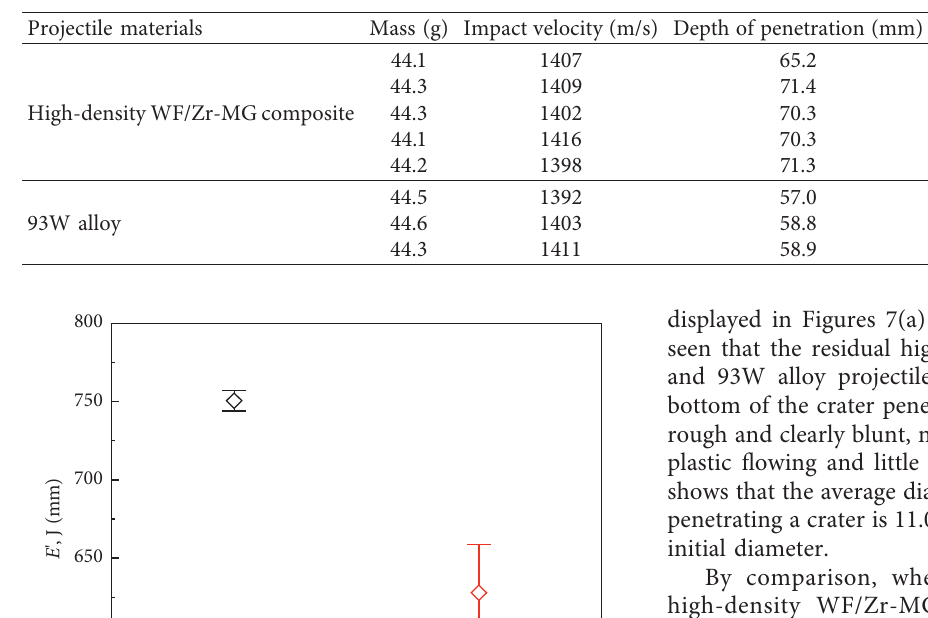
Figure 5: View of the target plate after penetration of the front (a) and back (b). Table 2: Impact velocity, mass, and penetration depth of projectiles.